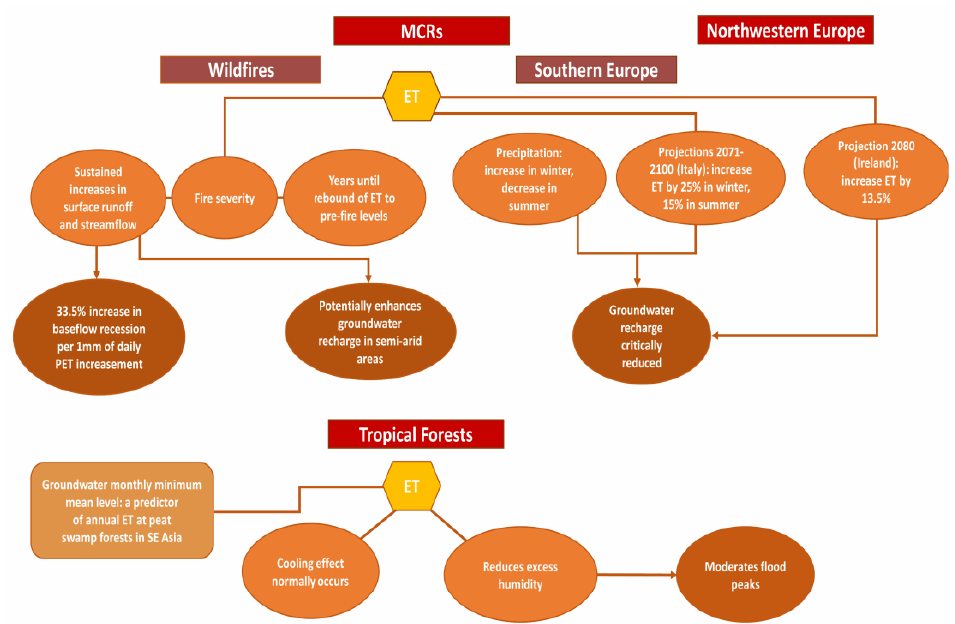
Figure 3. The main effects of ET variability on surface and ground water over Mediterranean Climate Regions, Northwestern Europe, and Tropical forests.